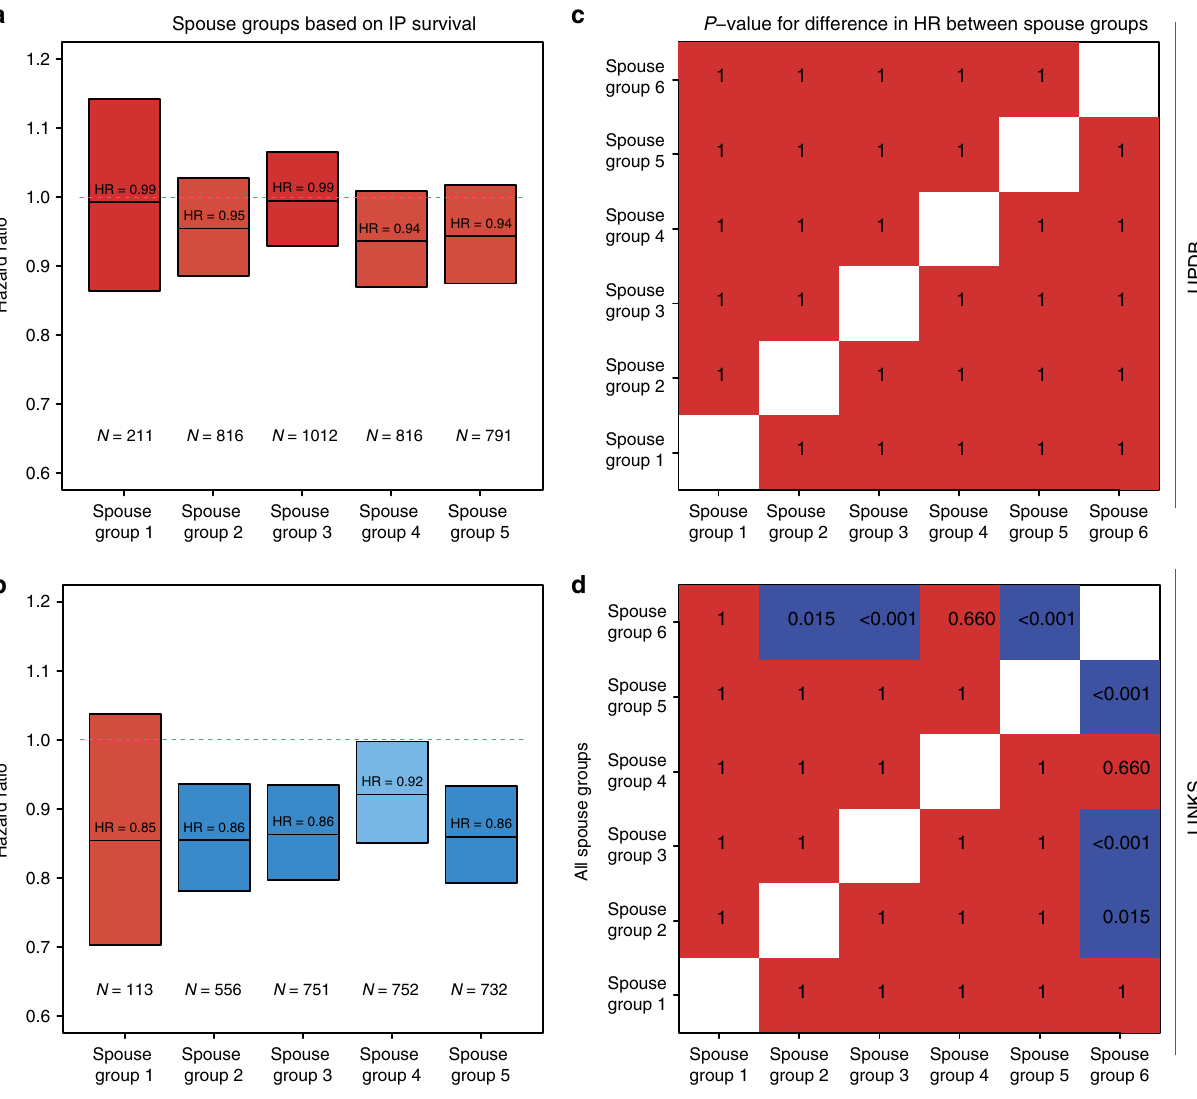
Fig. 4 Hazard ratio for spouses grouped by IP survival in mutual exclusive groups. Spouse groups: group 1 = spouses of whom the IP belonged to the [ ≥ 0th & ≤ 1th percentile] of their birth cohort, group 2 = spouses of whom the IP belonged to the [ ≥ 1th & ≤ 5th percentile] of their birth cohort, group 3 = spouses of whom the IP belonged to the [ ≥ 5th & ≤ 10th percentile] of their birth cohort, group 4 = spouses of whom the IP belonged to the [ ≥ 10th & ≤ 15th percentile] of their birth cohort, group 5 = spouses of whom the IP belonged to the [ ≥ 15th & ≤ 20th percentile] of their birth cohort, group 6 = spouses of whom the IP belonged to the [ ≥ 20th & ≤ 100th percentile] of their birth cohort. The left column (panels a and b ) shows the HRs of groups 1 – 5 compared to group 6. Groups were colored by the extremity of the HR. The darker the blue the stronger the survival bene fi t, the darker the red, the weaker the survival bene fi t and the effect was not signi fi cant with the red colors. The green lines represent the reference category, which is group 6. N green line at the top-left = 8065, N green line at the bottom-left = 7887. The right column (panels c and d ) represents a post-hoc test of all groups and illustrates the p -values for the differences in HR between the spouse groups. p -Values are estimated with Cox regression. Blue color indicates a statistically signi fi cant effect after Bonferroni correction, red color indicates a non-statistically signi fi cant effect after Bonferroni correction. All estimates are adjusted for religion (UPDB only), sibship size, birth cohort, sex, socio-economic status, mother ’ s age at birth, birth order, birth intervals, and twin birth. Error bars represent con fi